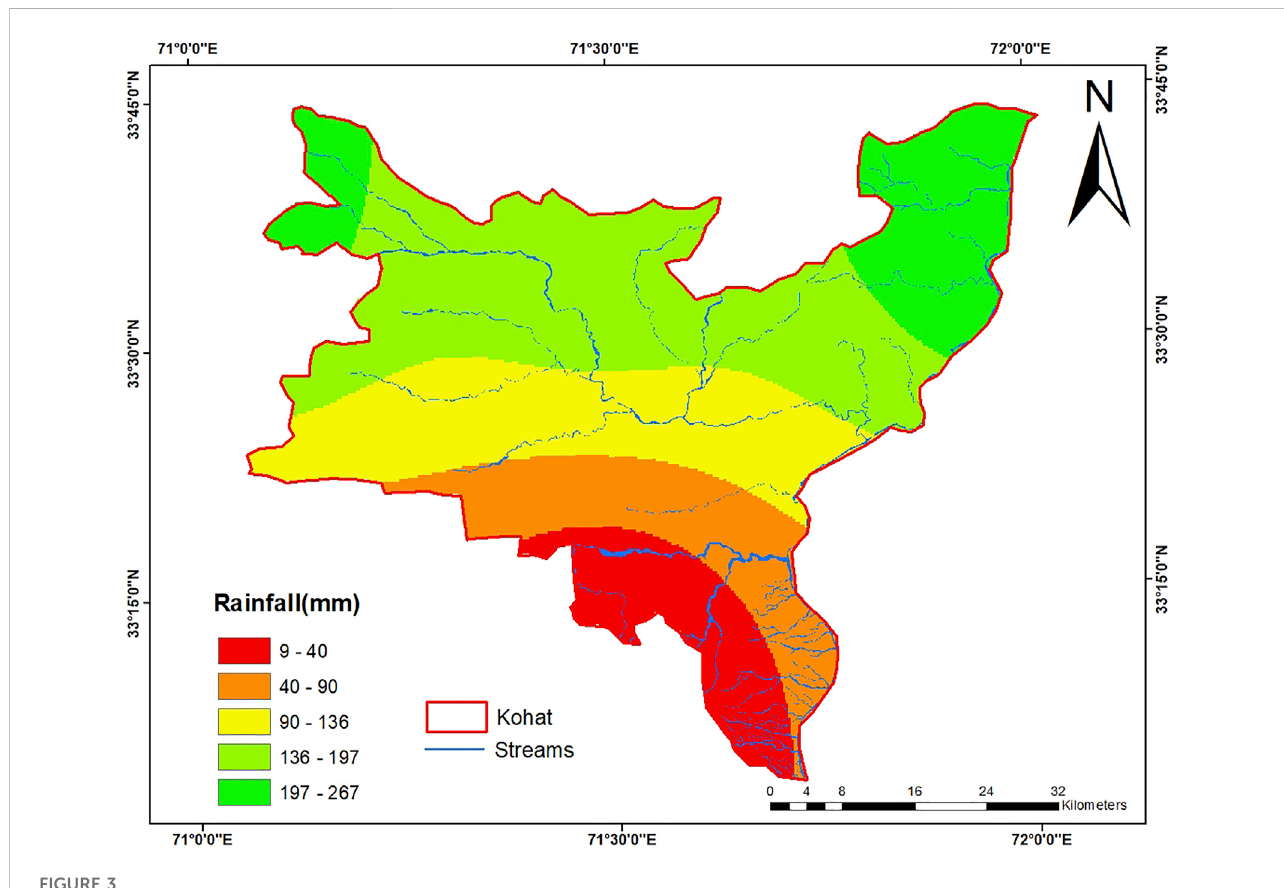
FIGURE 3 Rainfall map of the study